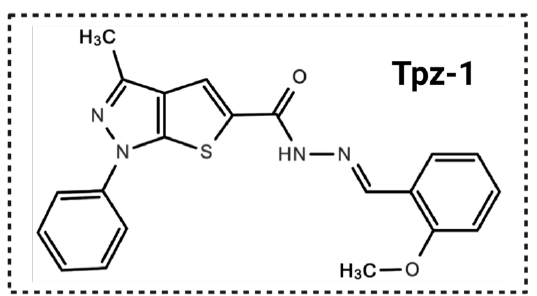
Figure 2. Chemical structure of thieno[2,3-c]pyrazole derivative Tpz- 1 (N’ -(2-methoxybenzylidene)- 3-methyl-1-phenyl-1H-thieno[2,3-c]pyrazole-5-carbohydrazide; MW: 390 g/mol).